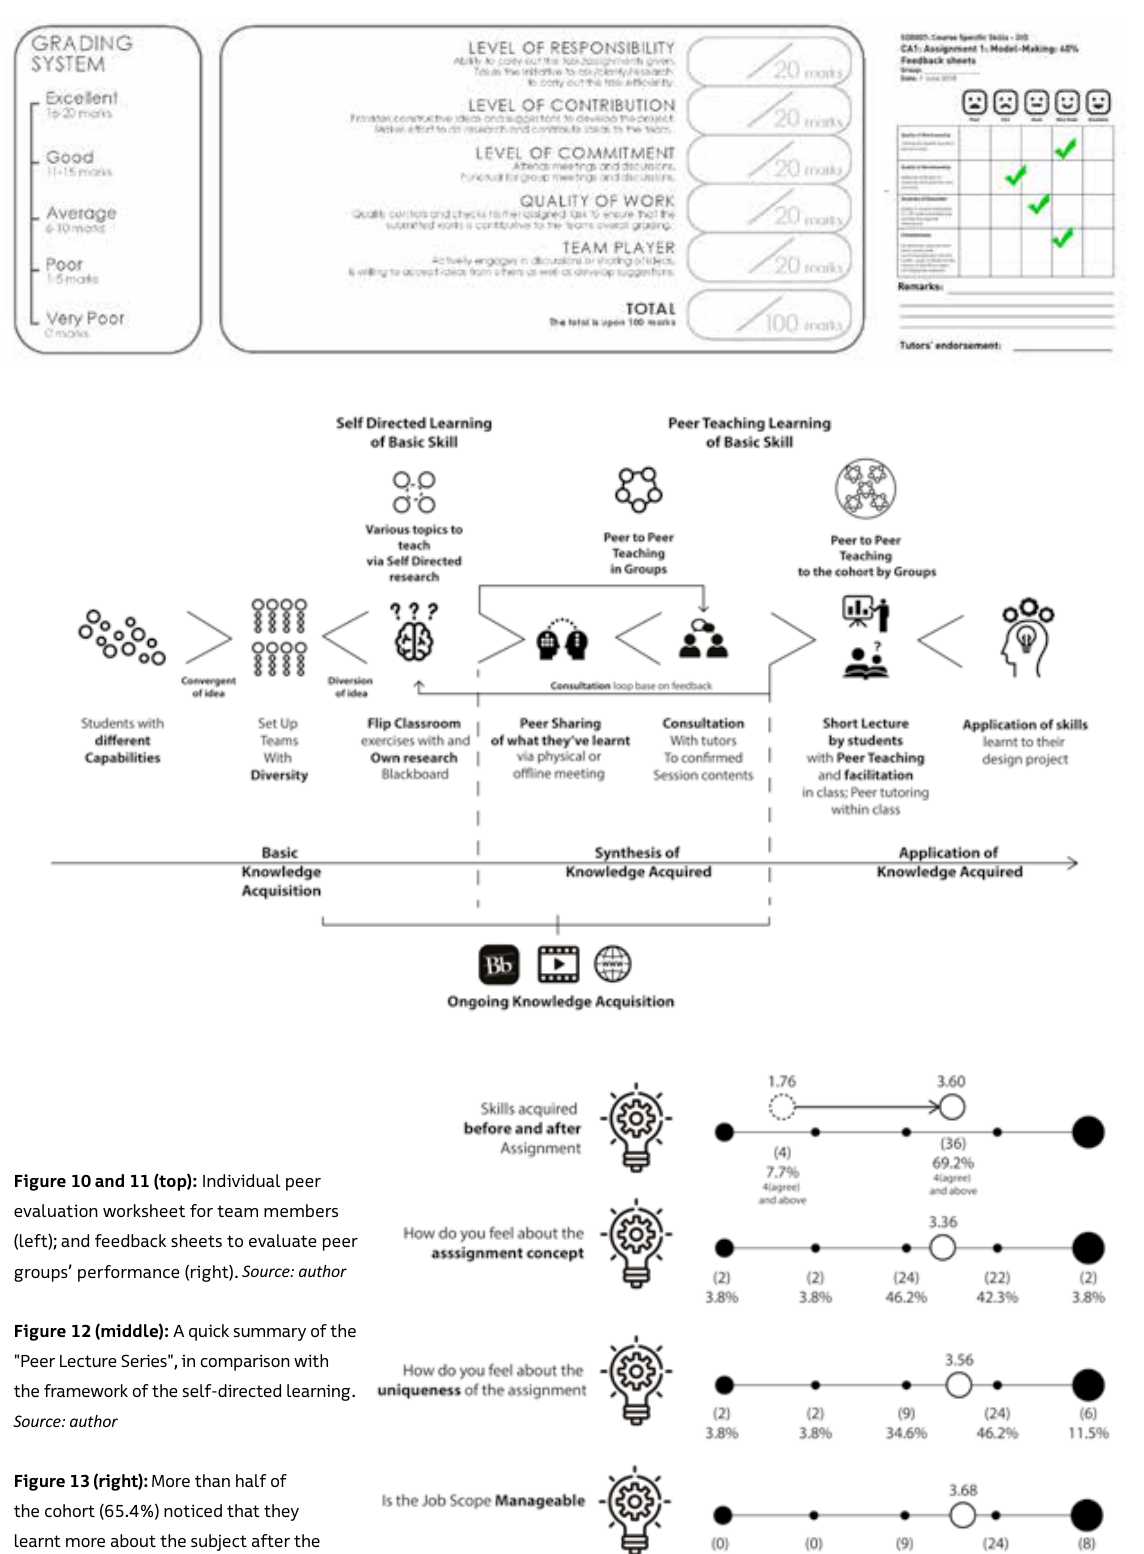
Figure 13 (right): More than half of the cohort (65.4%) noticed that they learnt more about the subject after